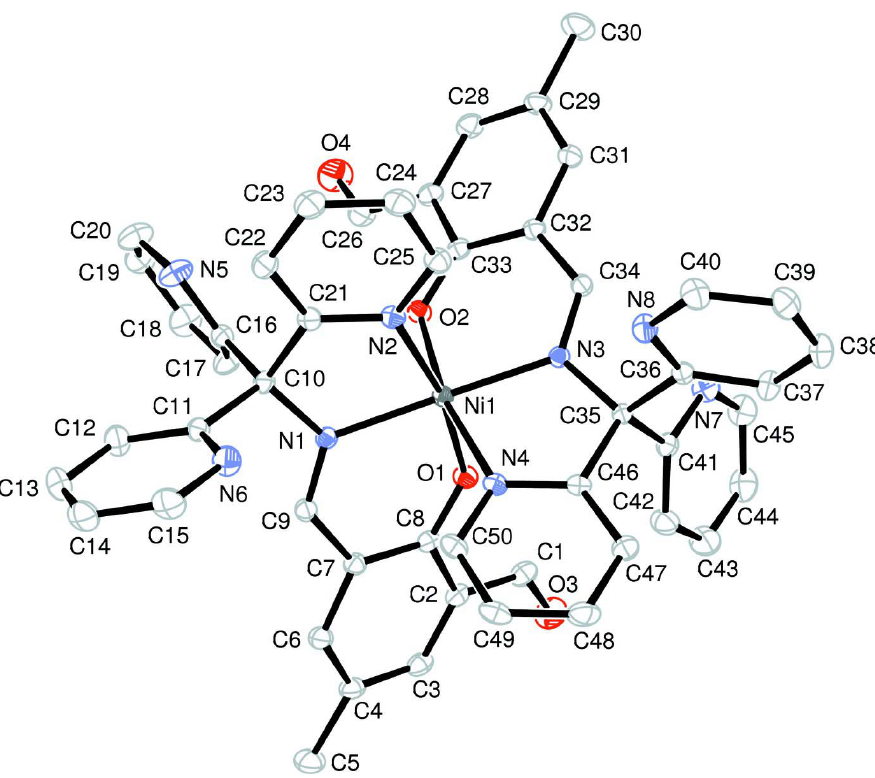
Figure 1 The molecular structure of (I) with displacement ellipsoids drawn at the 30% probability level. H atoms have been omitted for